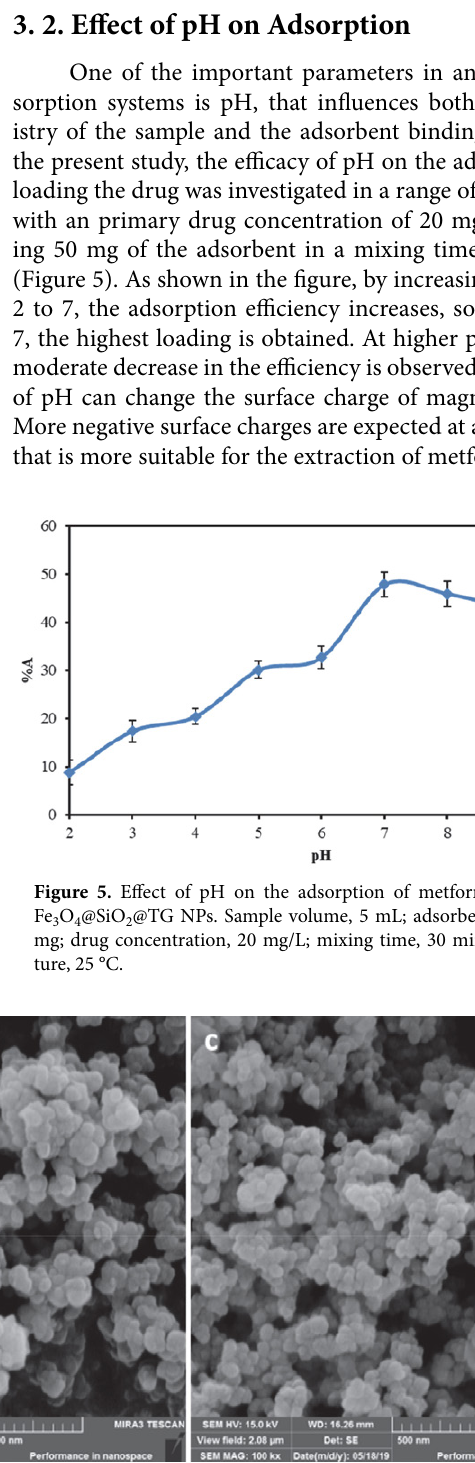
Figure 4. SEM images of Fe 3 O 4 (a), Fe 3 O 4 @SiO 2 (b) and Fe 3 O 4 @SiO 2 @GT (c) MNPs.